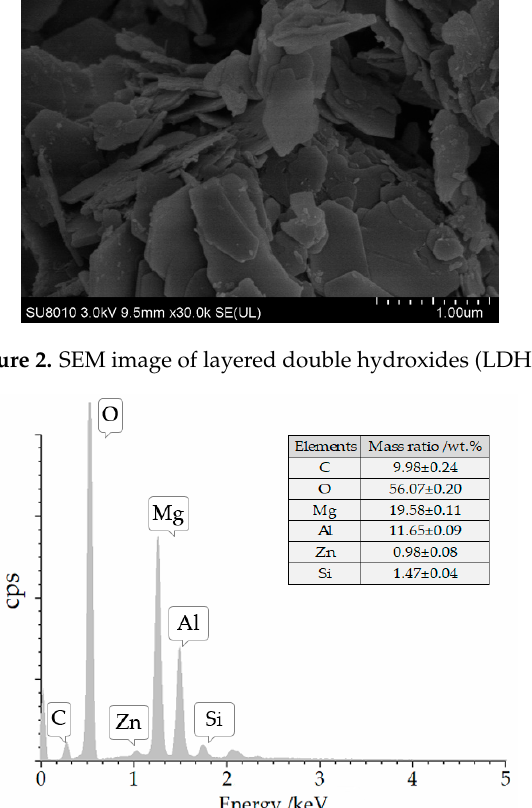
Figure 3. Energy-dispersive spectrometer (EDS) spectrum of LDHs.